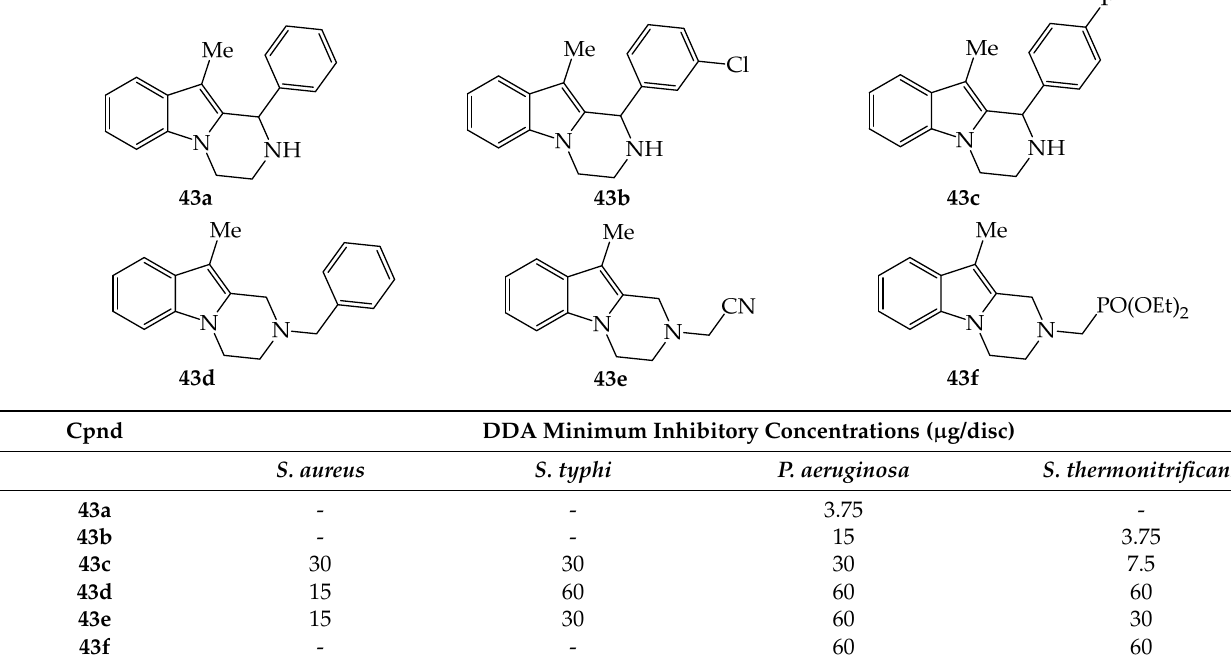
Table 2. Anti-fungal properties of tetrahydro-pyrazinoindoles 43g–I and 43c .